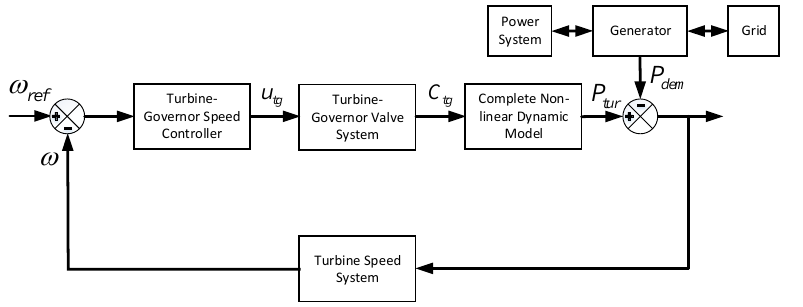
Figure 2. Block diagram of turbine-speed control